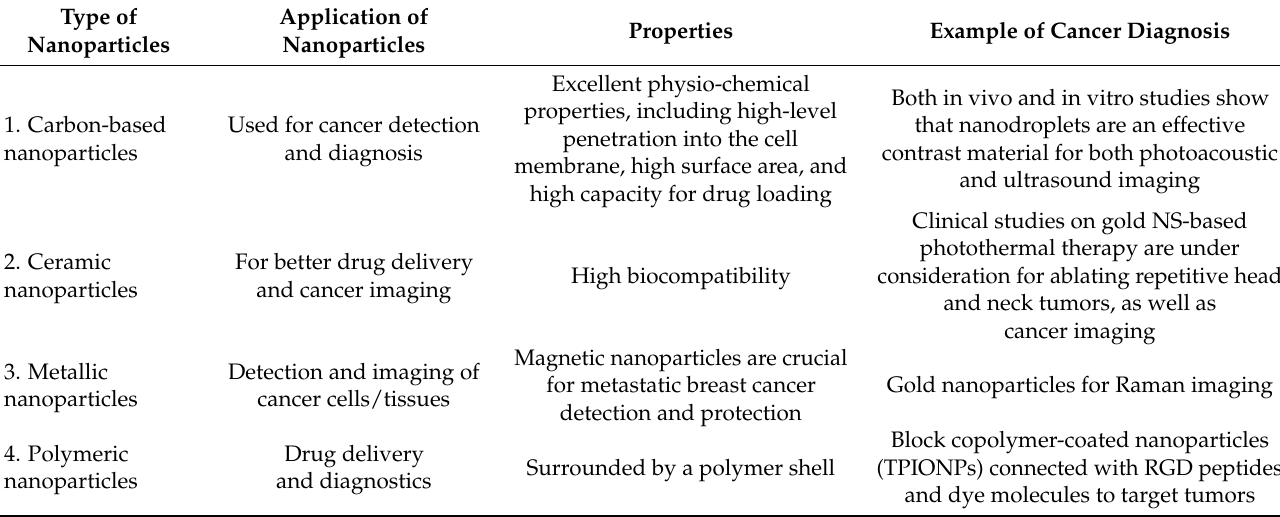
Table 1. Application of nanoparticles in cancer diagnosis [16].